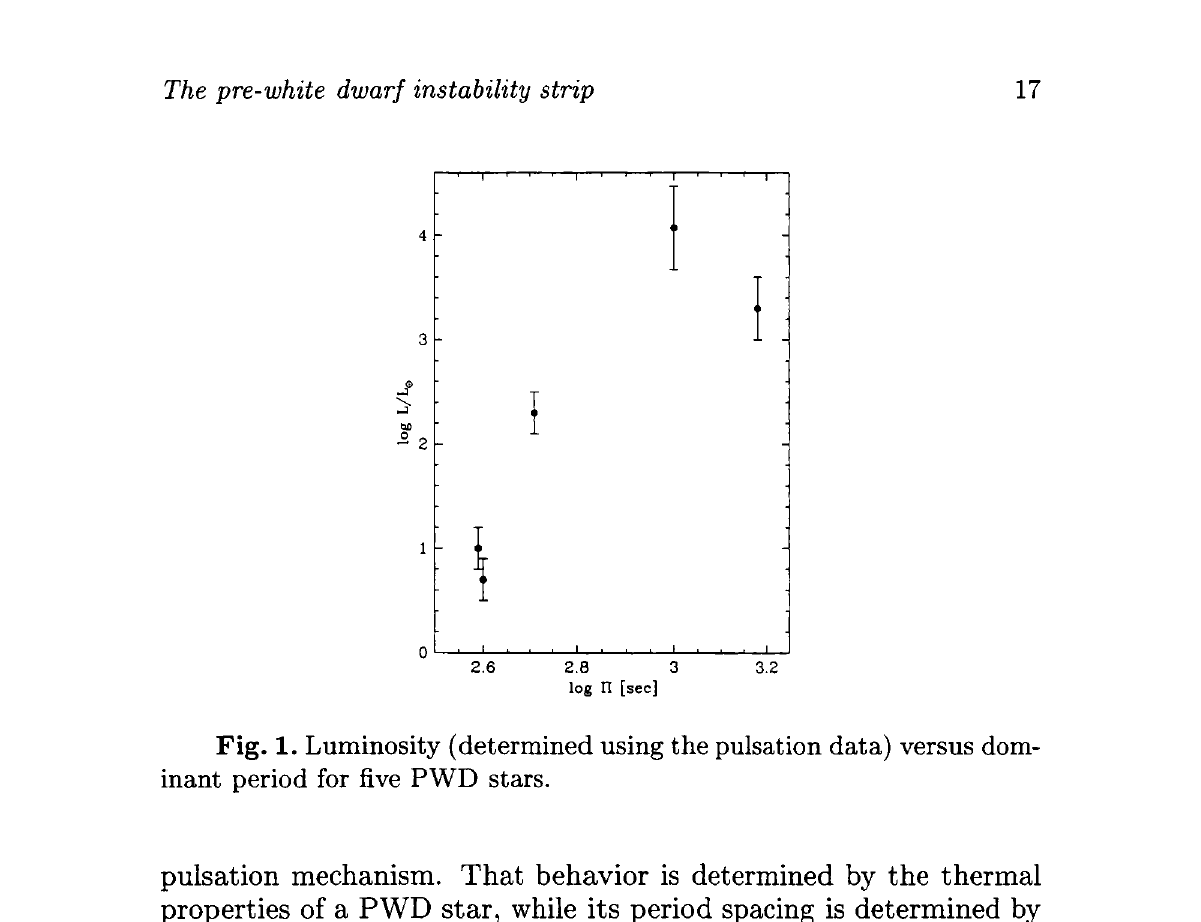
Fig. 1. Luminosity (determined using the pulsation data) versus dom- inant period for five PWD